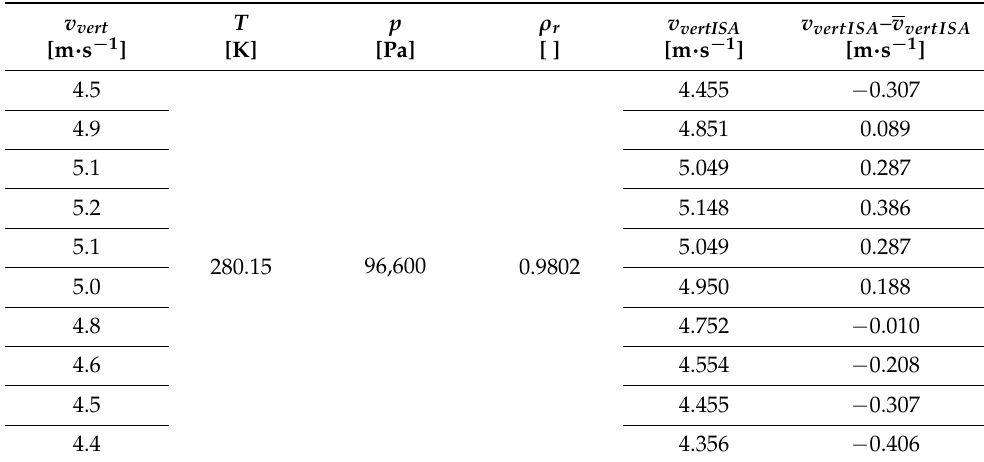
Table 4. v vert ISA using the device FLYTEC 4030—test jump number 1.